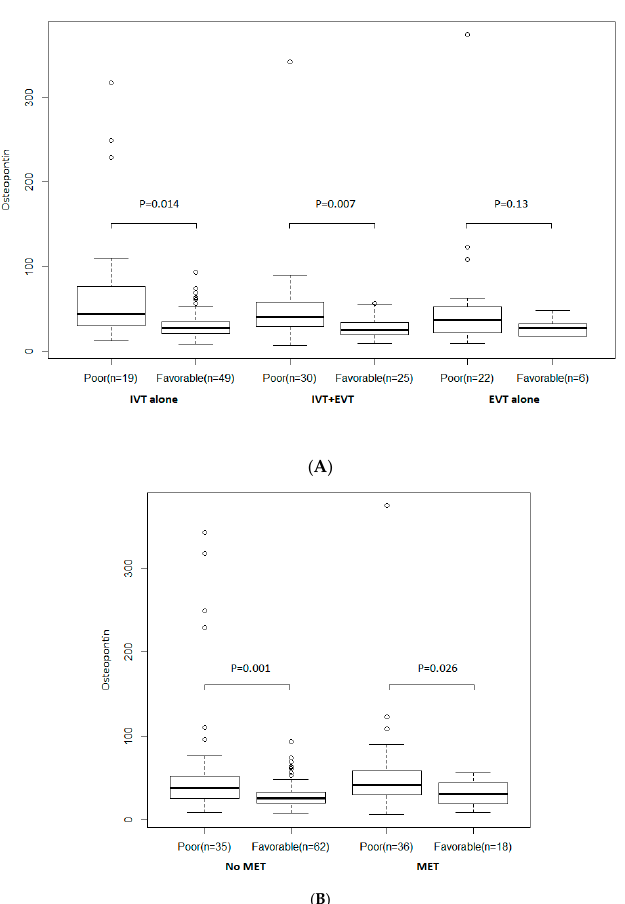
Figure 2. ( A ) According to treatment strategy. ( B ) According to mechanical endovascular treatment (MET). Distribution of osteopontin according to a favorable outcome and AIS treatment. Boxes show the 25th, 50th, and 75th percentiles, and unadjusted p -values (Student’s t-test on log-transformed values) are reported. Abbreviations: EVT = endovascular treatment; IV = intravenous thrombolysis; MET = mechanical endovascular treatment.